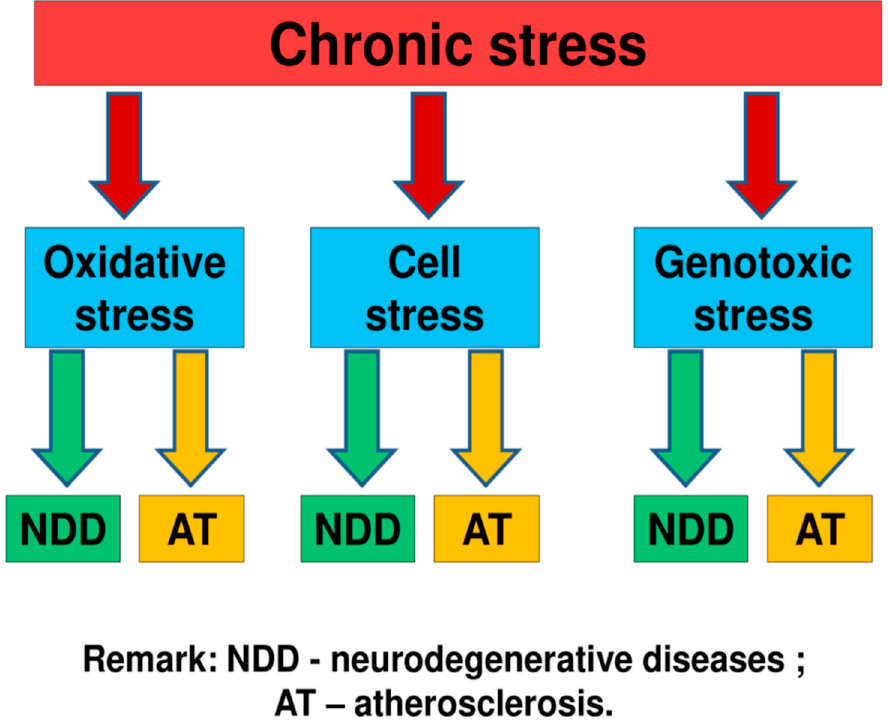
Figure 2. Some mechanisms of the link of chronic stress with neurodegenerative diseases and atherosclerosis [8–16]. We suppose that the most important role in this process play molecular and cellular types of stress. Among molecular types of stress, the largest contribution to pathogenesis of neurodegenerative diseases and atherosclerosis can make oxidative and genotoxictypes of stress.